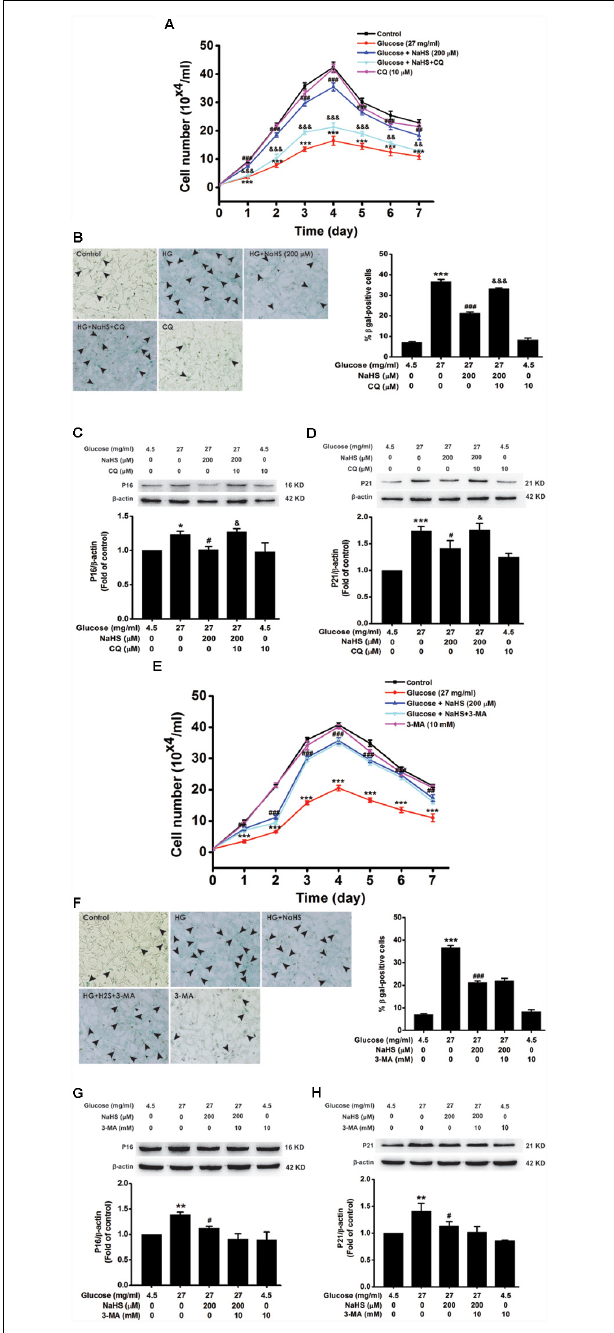
FIGURE 4 | Effects of CQ and 3-MA on the protection of H 2 S against HG-induced cellular senescence in HT22 cells. (A,E) Cell growth curves were generated by using Trypan blue stain assays. (B,F) Representative images of senescent cells that were stained for SA- β -gal (Left, Magnification × 10) and quantitative analysis of the SA- β -gal positive cells (Right). The black arrows indicate the senescent cells, n = 5. (C,D,G,H) The expressions of p16 INK4a and p21 CIP1 in HT22 cells were detected by Western blotting. Values were expressed as the mean ± SEM, n = 3. ∗ P < 0.05, ∗∗ P < 0.01, ∗∗∗ P < 0.001, vs. control group; # P < 0.05, ## P < 0.01, ### P < 0.001 vs. HG-treated alone group. & P < 0.05, && P < 0.01, &&& P < 0.001, vs. co-treated with NaHS and HG